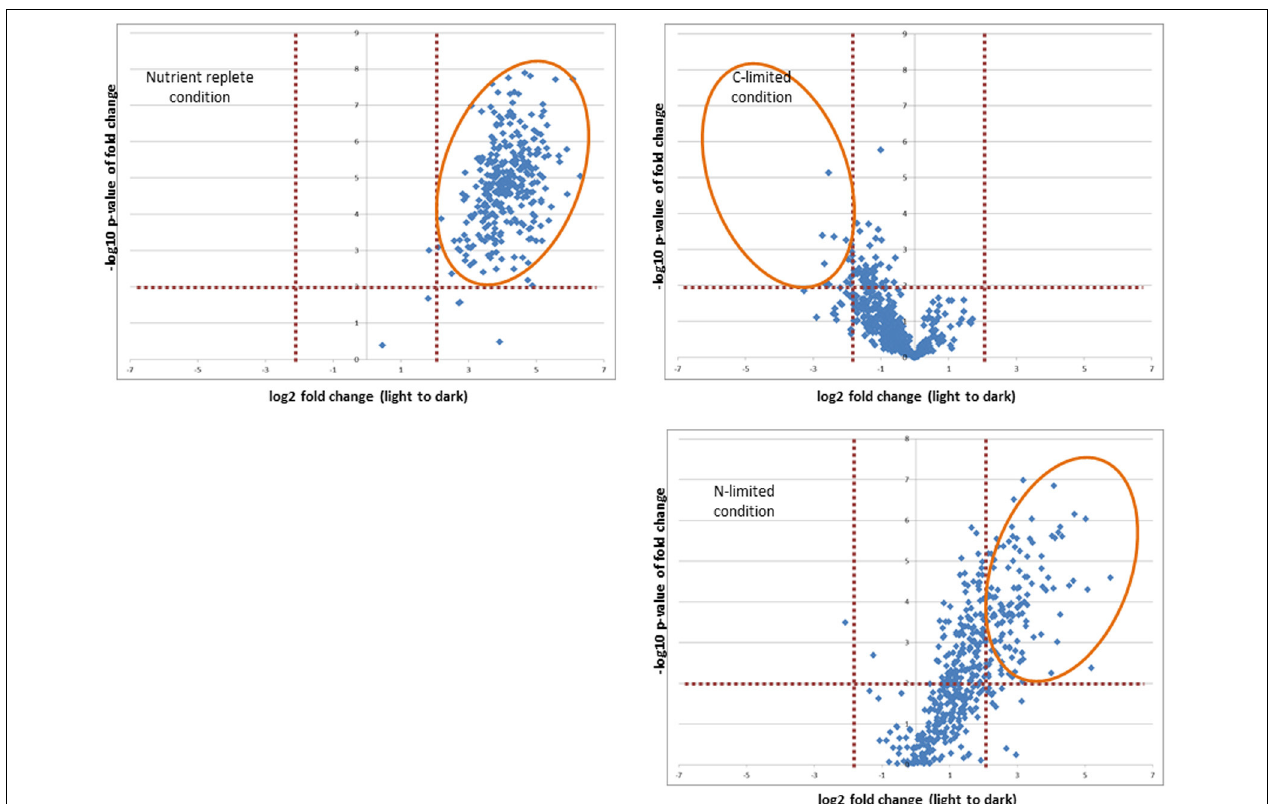
FIGURE 5 | Effect of shift from light to dark to on the capacity for reductant transfer to proteins under each nutrient limitation. Orange elipticals highlight significantly changing proteins ( p -values < 0.01 and log2 fold change > 2 or < −